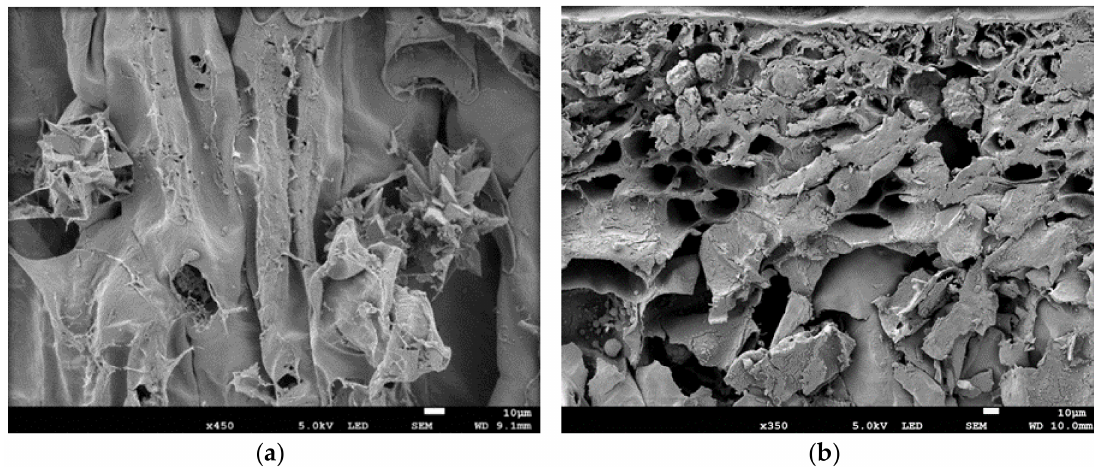
Figure 2. Fresh cladode parenchyma cells demonstrating different calcium oxalate crystal morphologies as ( a ) Opuntia ficus-indica (40–60 µ m at × 450): three large whewellite stellate druses; ( b ) Opuntia robusta ( ± 25 µ m at × 550): three smaller crystals close to the